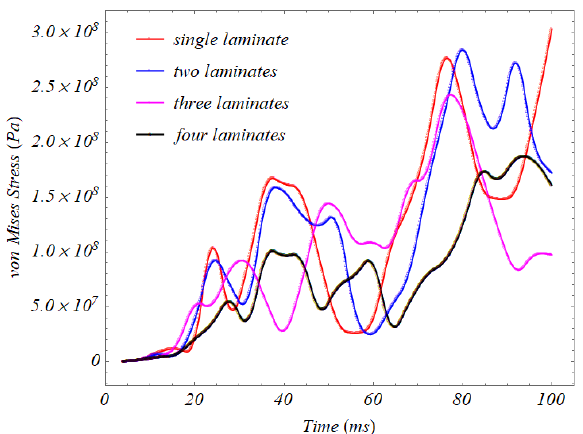
Fig. 20 von Mises stress against time for various number of cellphone casing laminates at 2500 mm drop